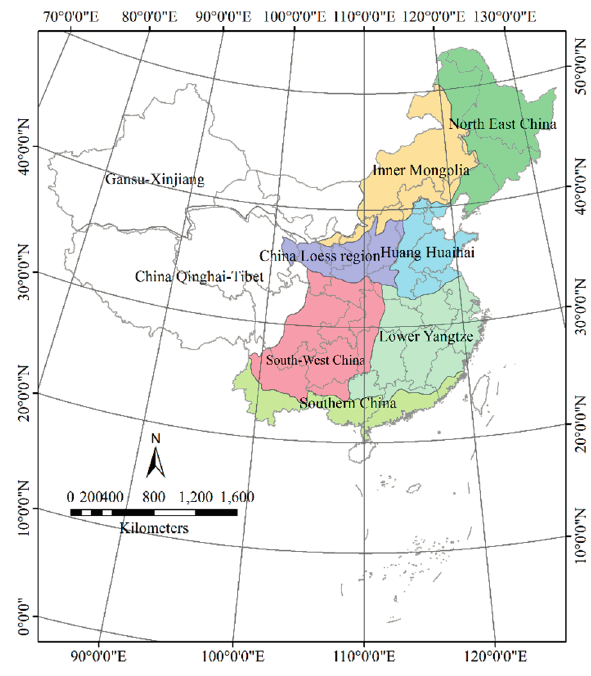
Figure 3. Seven crop monitoring sub-divisions adopted by the CropWatch System for China (modified from Sun (1994)